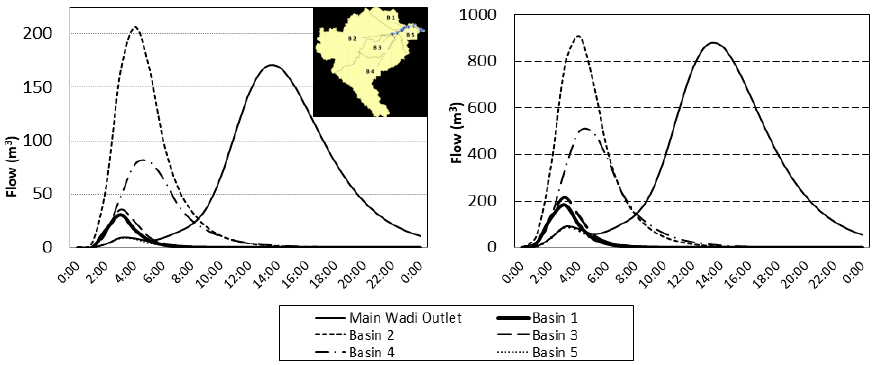
Figure 7. The modeled hydrographs showing the range of discharges predicted for the main five sub-basins of Wadi El-Ambagi under 2-hour hypothetical rainstorms of 30 mm ( left ) and 60 mm ( right ). The analysis shows that within the El-Ambagi watershed, there are 36 sub-basins that drain toward the Qift–Quseir highway: 18 basins from the north and 18 from the south. The hazard level demonstrated by each sub-basin, as shown in Figure 8 and Table 1, varies in regard to their physiographic characteristics, drainage network, and soil properties.